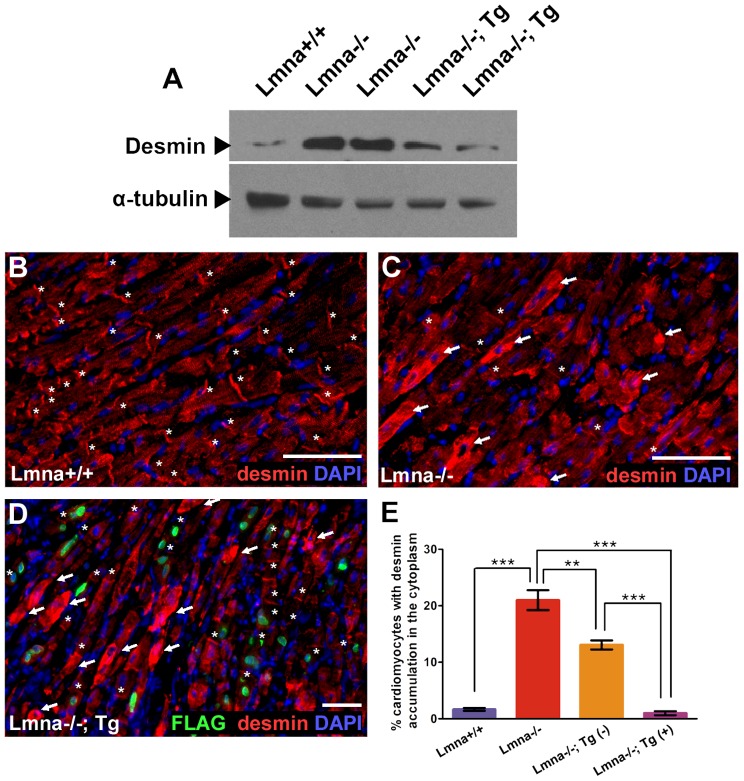
Transgenic expression of lamin A in Lmna
−/− cardiomyocytes results in partial restoration of desmin phenotype but not cardiac remodeling markers.(A) Western blot analysis of Lmna
+/+, Lmna
−/−, and Lmna
−/−; Tg whole heart lysates. Desmin is increased in Lmna
−/− heart lysates compared to Lmna
+/+ and is partially attenuated in Lmna
−/−; Tg mice (middle blot). α-tubulin is shown as a loading control (bottom blot). (B–D) Indirect immunofluorescence micrographs showing desmin (red), FLAG (green), and DAPI (blue) in Lmna
+/+ (B), Lmna
−/− (C), and Lmna
−/−; Tg (D) heart ventricle sections. Asterisks mark intercalated discs, which co-localize with a pan-cadherin antibody (not shown) and arrows indicate ventricular myocytes with accumulated desmin in the cytoplasm. Scale bar denotes 50 µm. (D) Note the lack of ventricular myocytes positive for both desmin cytoplasmic accumulation and transgene expression. (E) Graph summarizing the desmin cytoplasmic accumulation phenotype observed in Lmna
−/− ventricular myocytes across different mouse backgrounds aged 5–7 weeks (N = 3 for Lmna
+/+, Lmna
−/−, and Lmna
−/−; Tg; ** P<0.01; *** P<0.001).